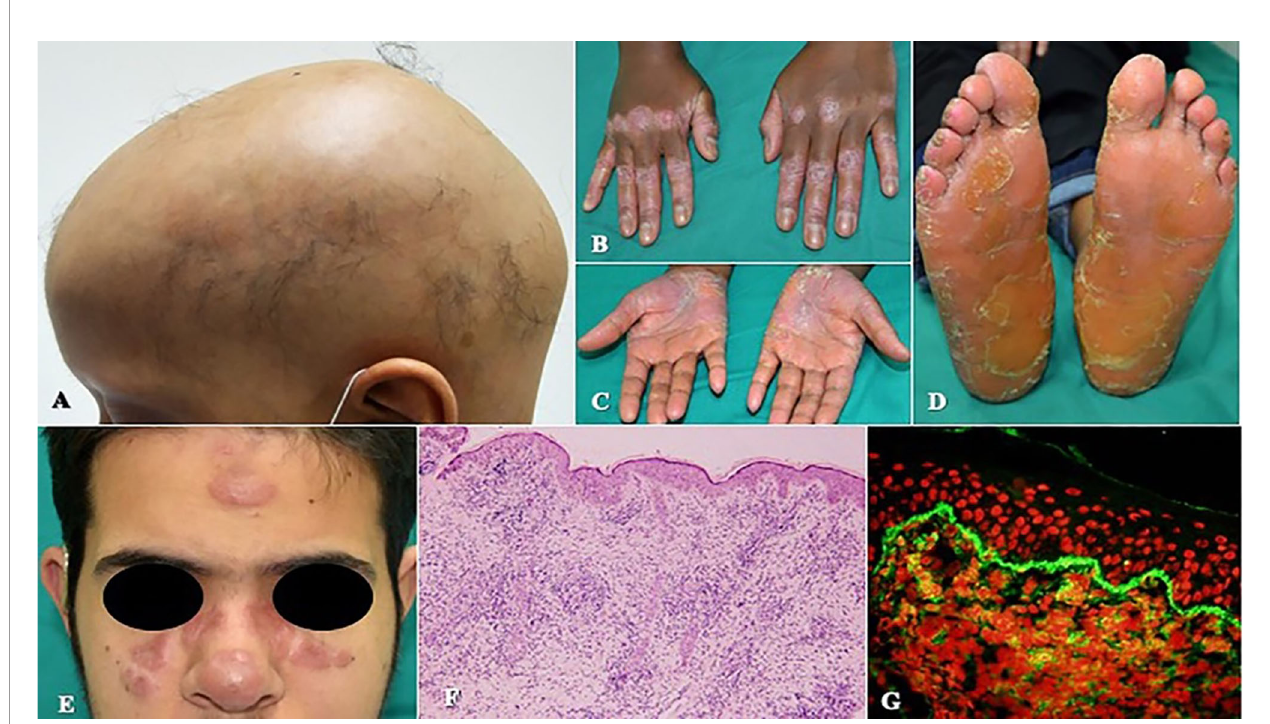
erythematosus, and direct immuno fl uorescence with granular deposition of IgM at the basement membrane zone in a patient with activation-induced cytidine deaminase ( AID ) de fi ciency.